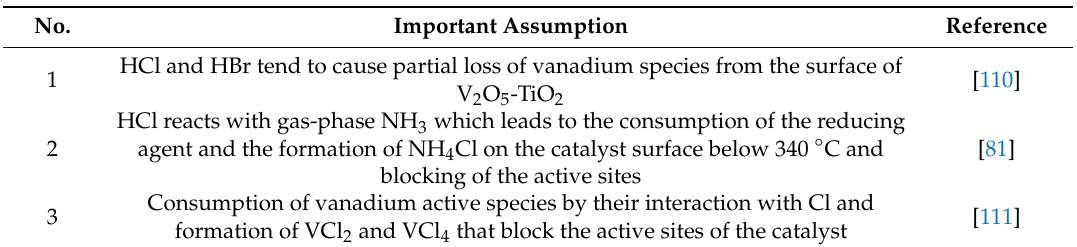
Table 7. The most important findings on the interaction of halogens with V 2 O 5 -TiO 2 . No.